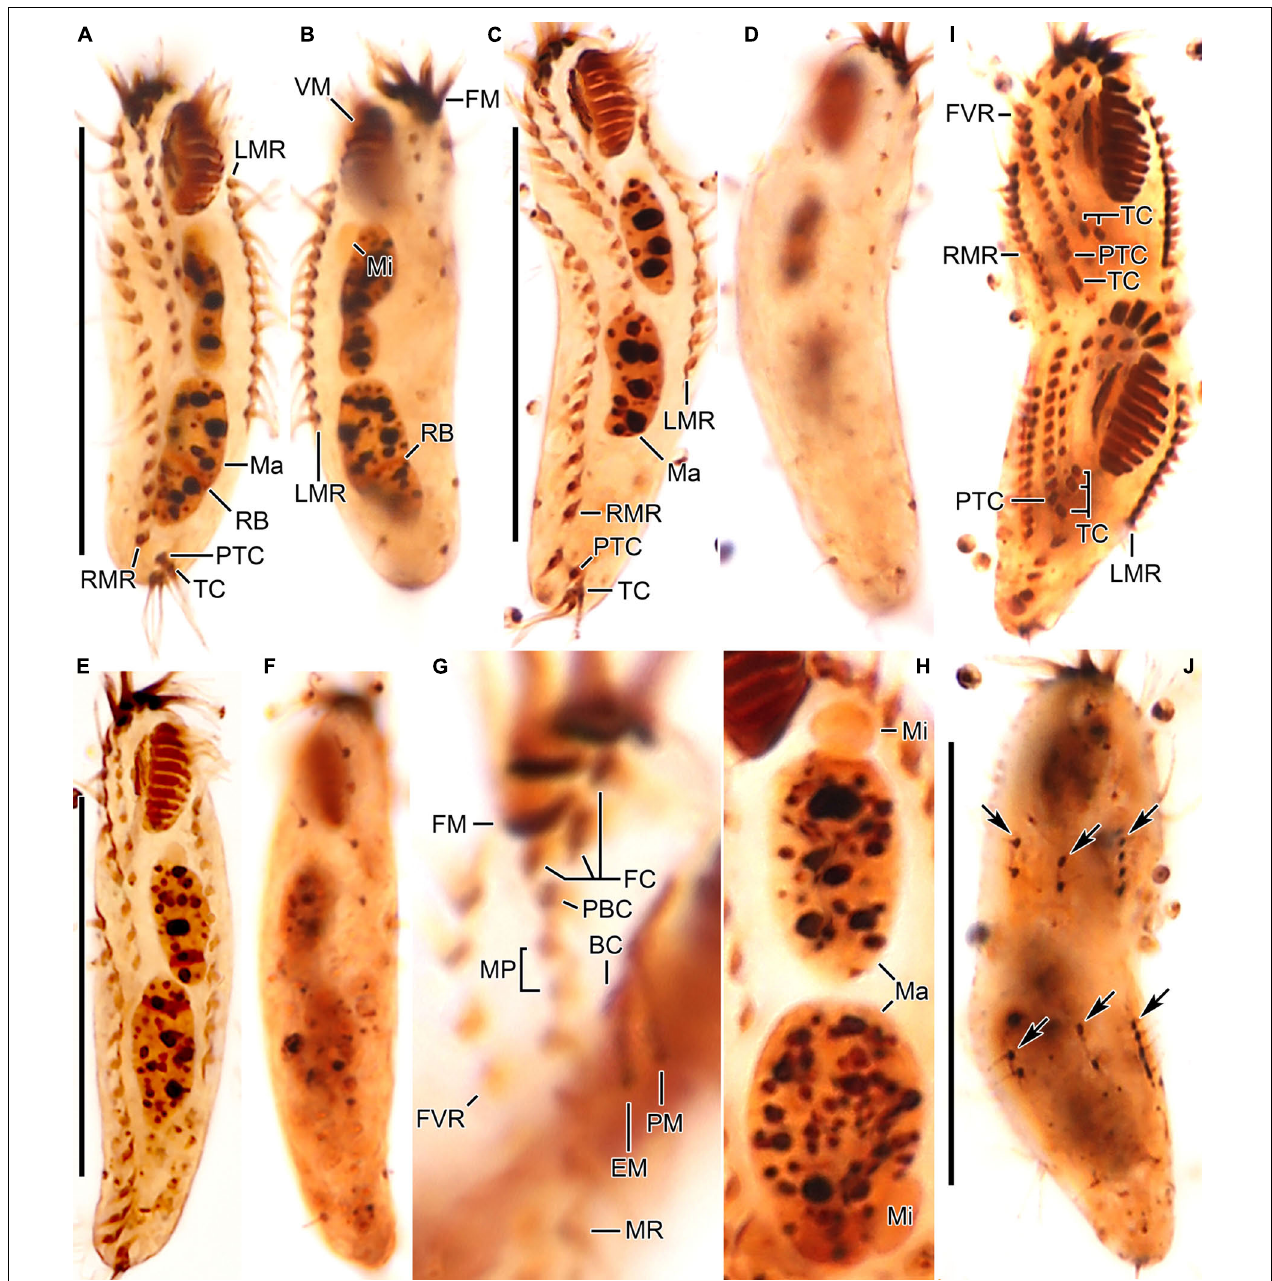
FIGURE 3 | Tunicothrix halophila n. sp. after protargol impregnation. (A,B) Ventral (A) and dorsal (B) views of the holotype specimen. (C–F) Ventral (C,E) and dorsal (D,F) views. (G) Ventral view showing cirri on right frontoventral area. (H) Nuclear apparatus. (I,J) Ventral (I) , and dorsal (J) view of a late divider. Arrows denote dorsal kinety anlagen. BC, buccal cirrus; DB, dorsal bristles; EM, endoral membrane; FC, frontal cirri; FM, frontal adoral membranelles; FVR, frontoventral row; LMR, left marginal row; Ma, macronuclear nodules; Mi, micronuclei; MP, midventral pair; MR, midventral row; PBC, parabuccal cirrus; PM, paroral membrane; PTC, pretransverse cirri; RB, replication band; RMR, right marginal row; TC, transverse cirri; VM, ventral adoral membranelles. Scale bars 30 µ m.